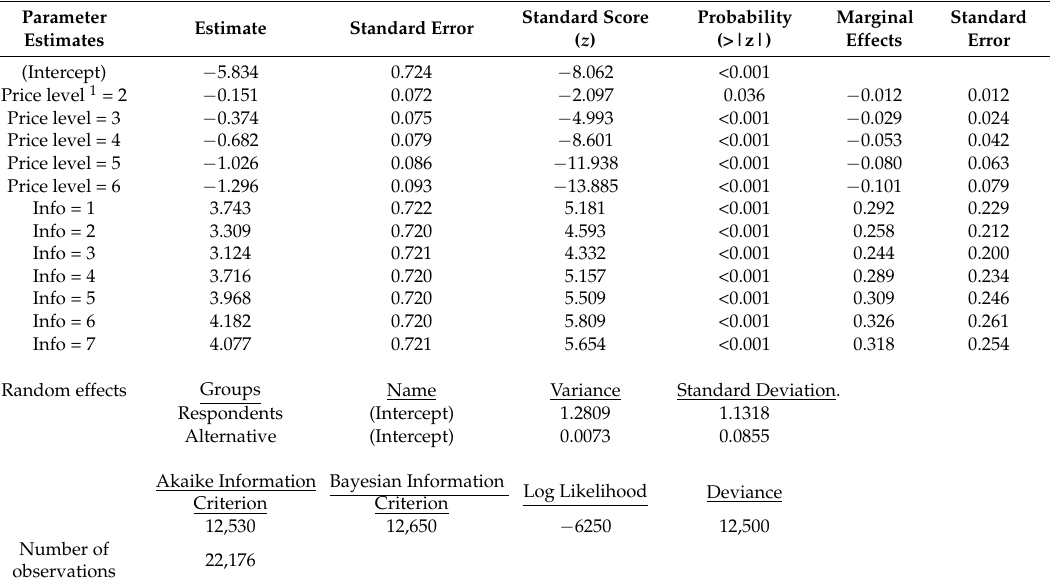
Table 5. Restricted Maximum Likelihood